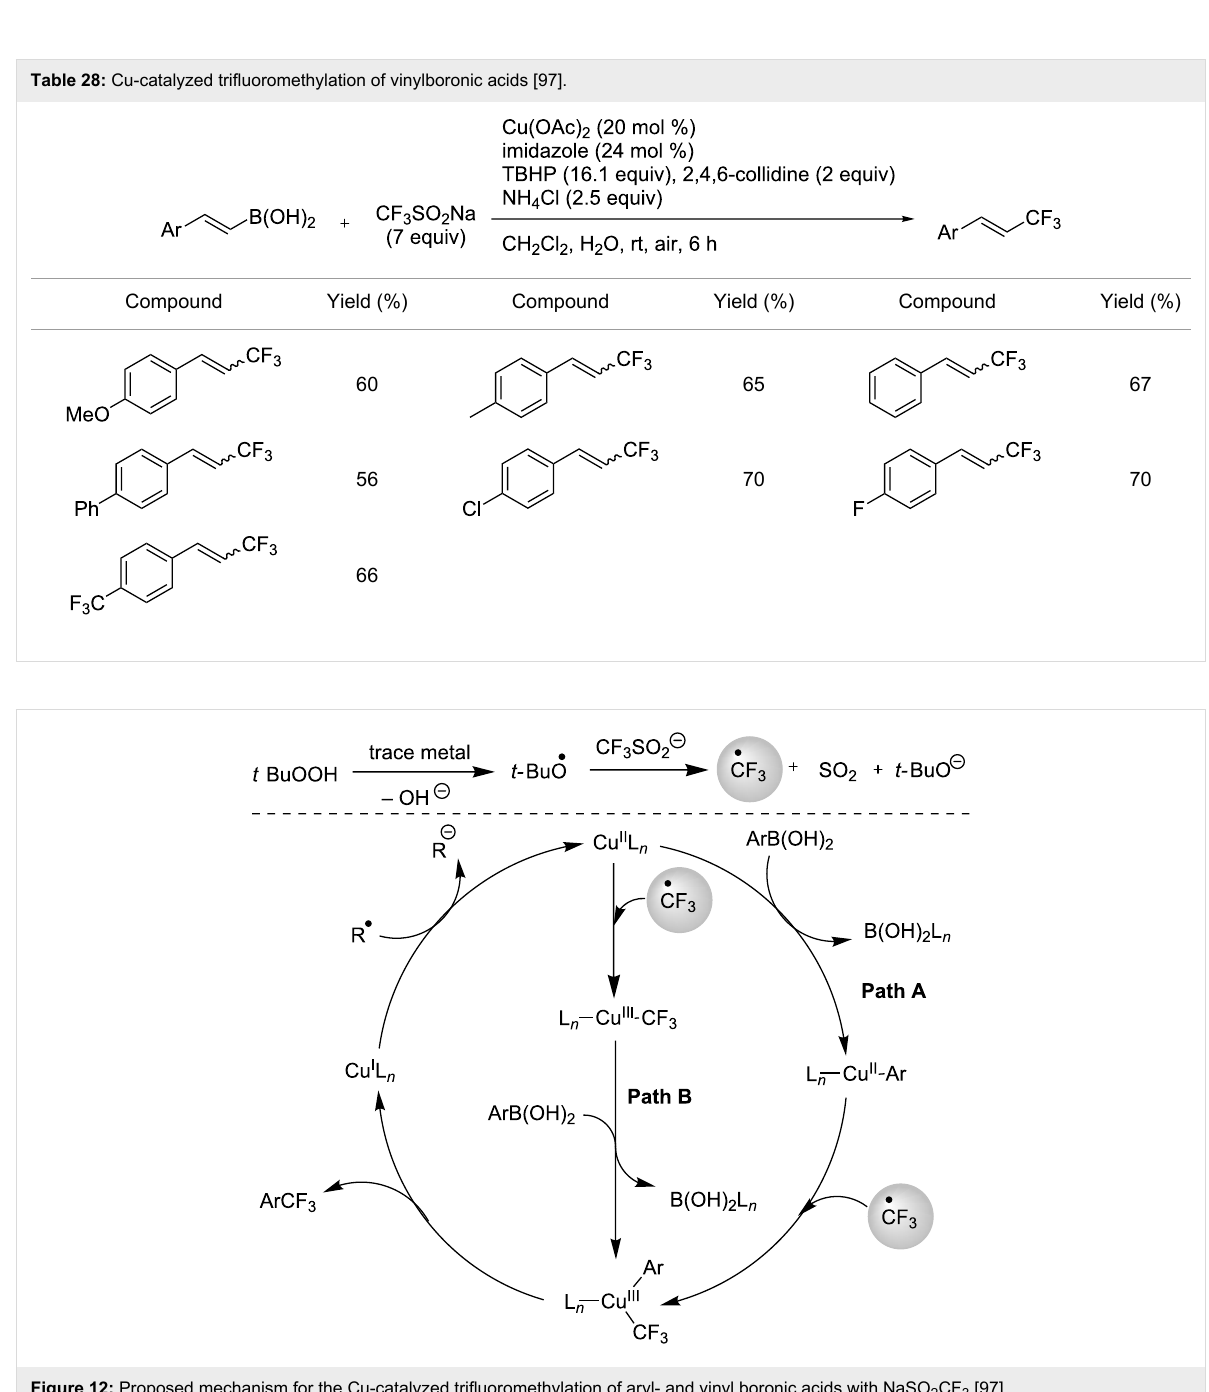
affords the arylcopper(III)CF 3 intermediate (Figure 12, Path